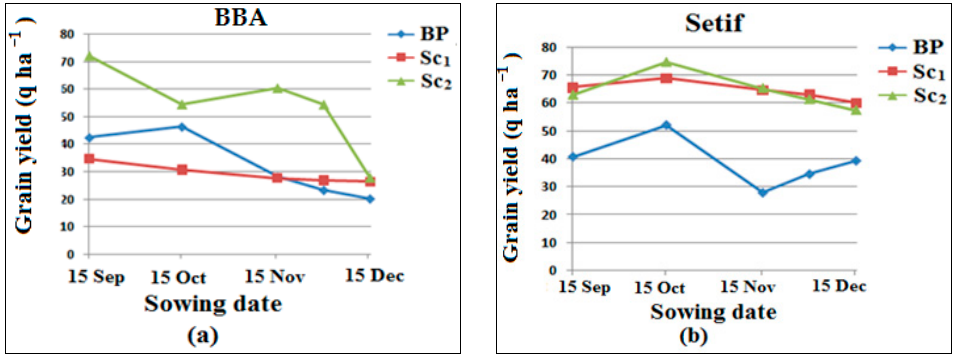
Figure 6. ( a , b ) Wheat grain yield simulated by AquaCrop by adjusting the sowing dates to adapt wheat crop to the future climate change projected under Sc 1 and Sc 2 at BBA and Setif sites